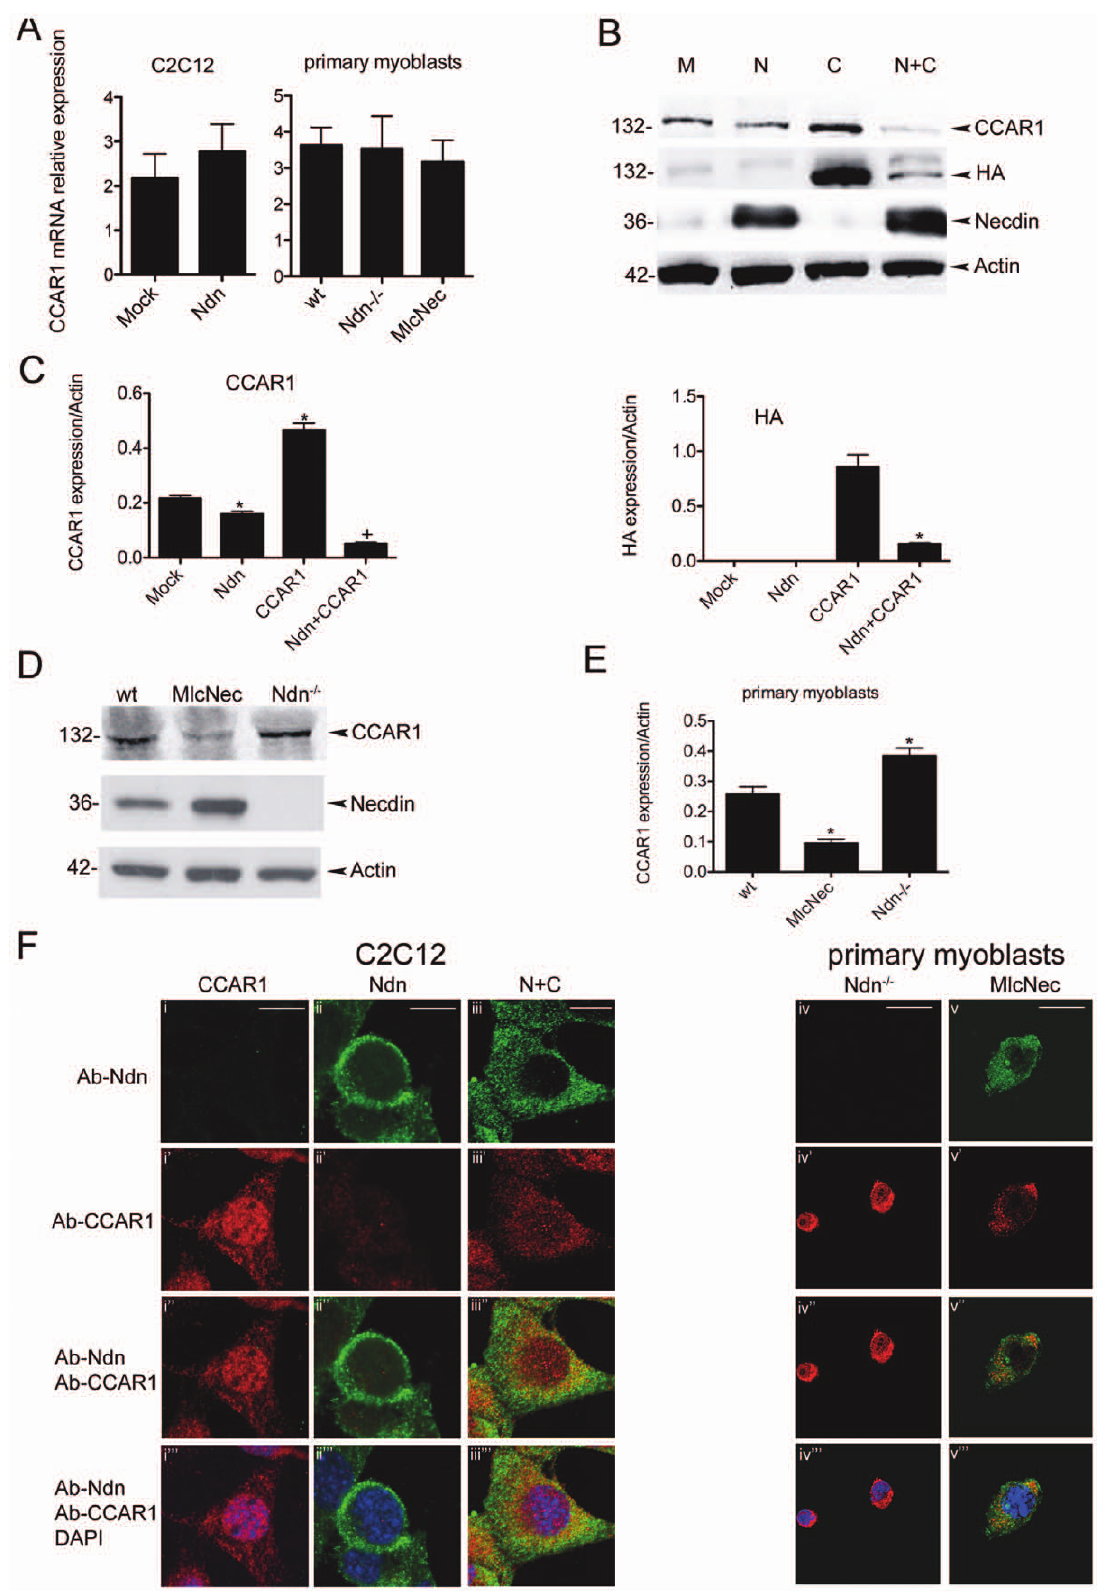
Figure 3. Necdin controls CCAR1 protein abundance in myogenic cells. A) CCAR1 mRNA relative quantification by qPCR using specific primers in C2C12 cells untransfected (Mock) or transfected with pCMV-FLAG-Necdin (Ndn) and in primary myoblasts from wt, Ndn 2 / 2 and tgMlcNec (MlcNec) mice (data representative of respectively four and three independent experiments). b -Actin was used as internal standards. B)